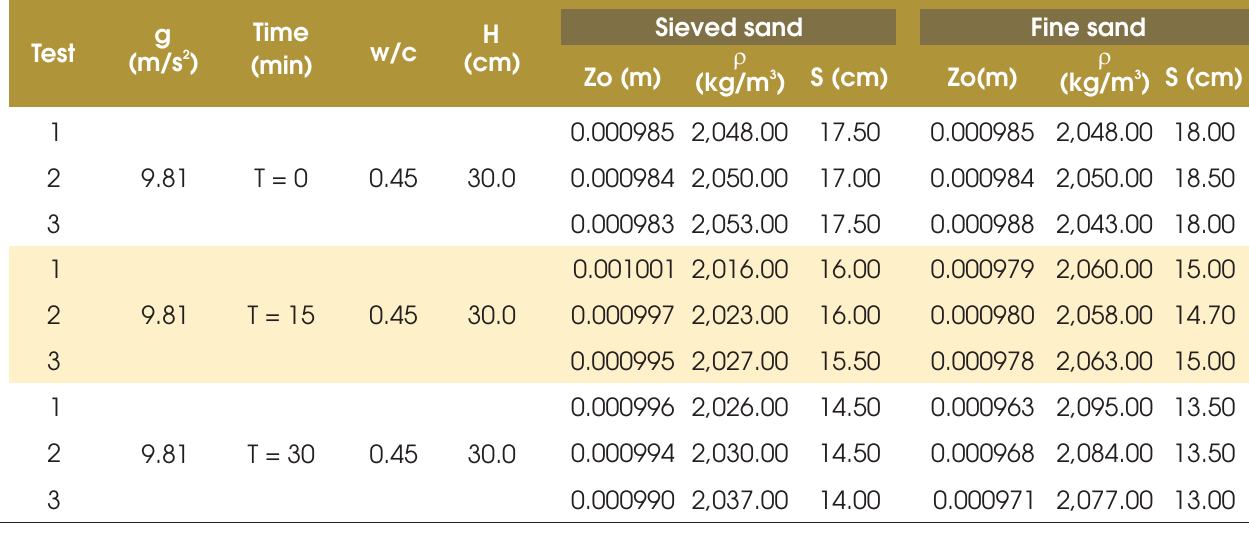
Table 9 – Method of Pashias: parameters needed to calculate the yield stress of the mortars with w/c = 0.45